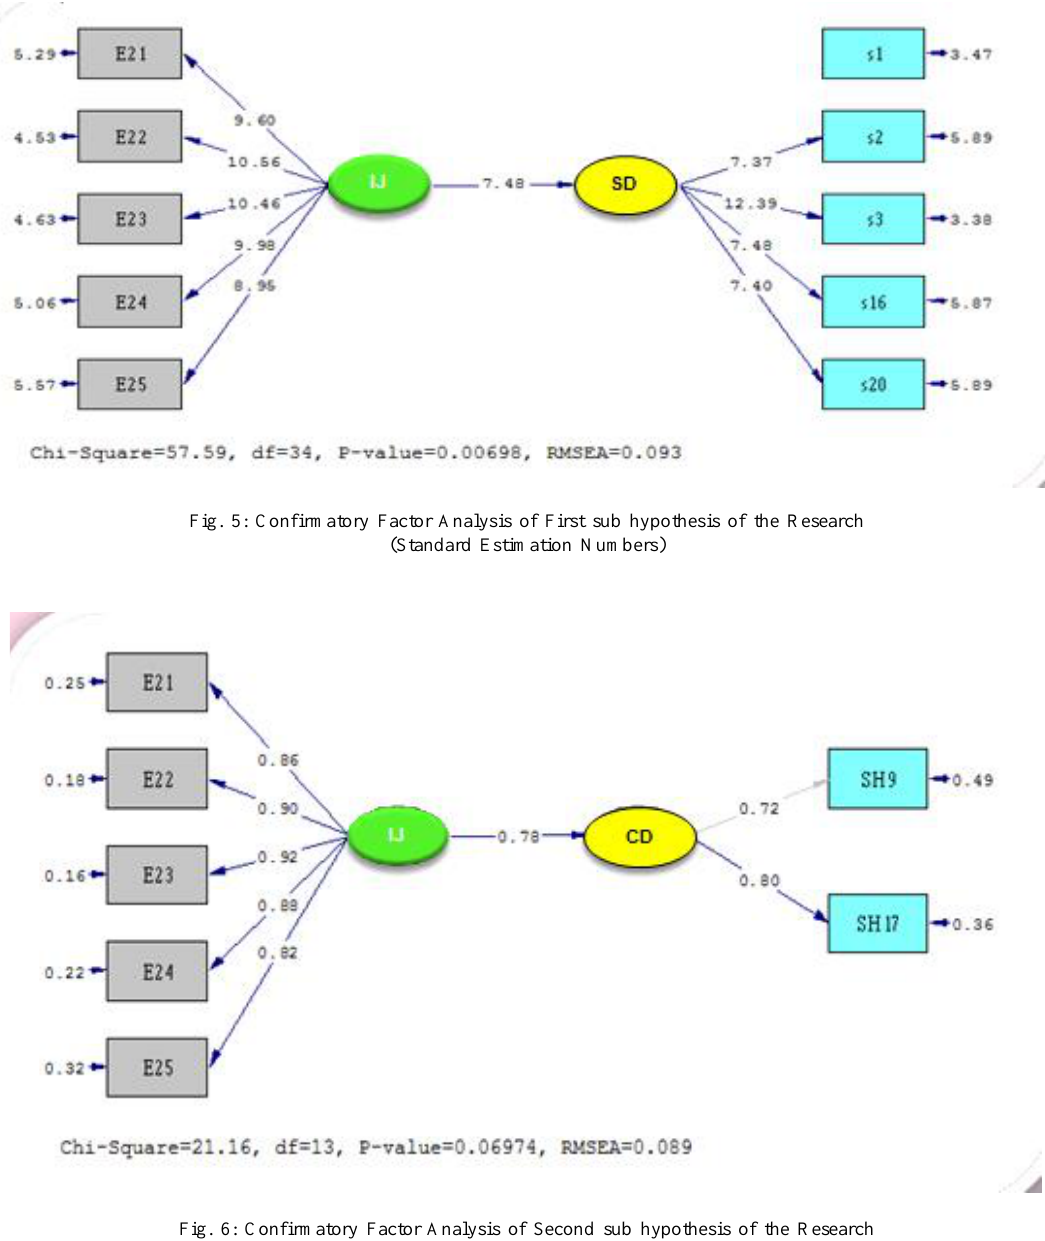
Fig. 6: Confirmatory Factor Analysis of Second sub hypothesis of the Research (Standard Estimation